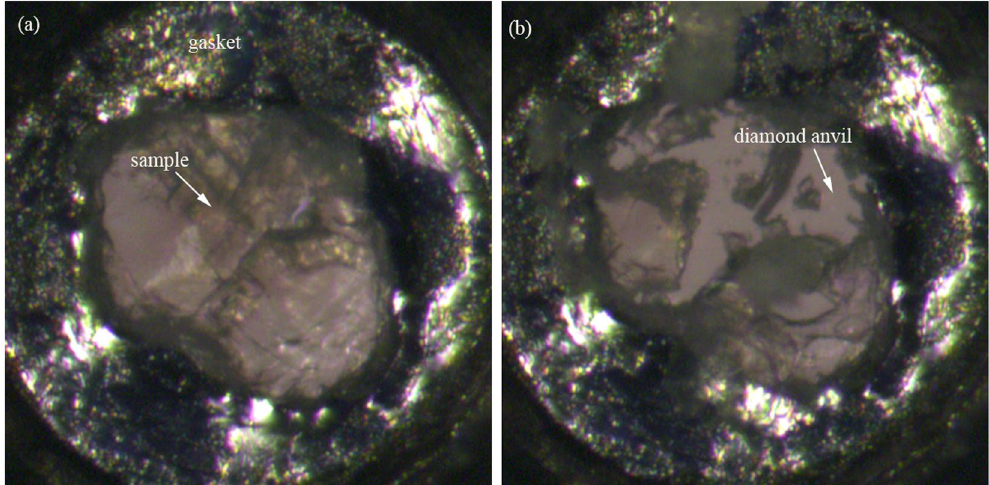
Figure 10. The final product of the p -xylene sample recovered from 20.1 GPa.